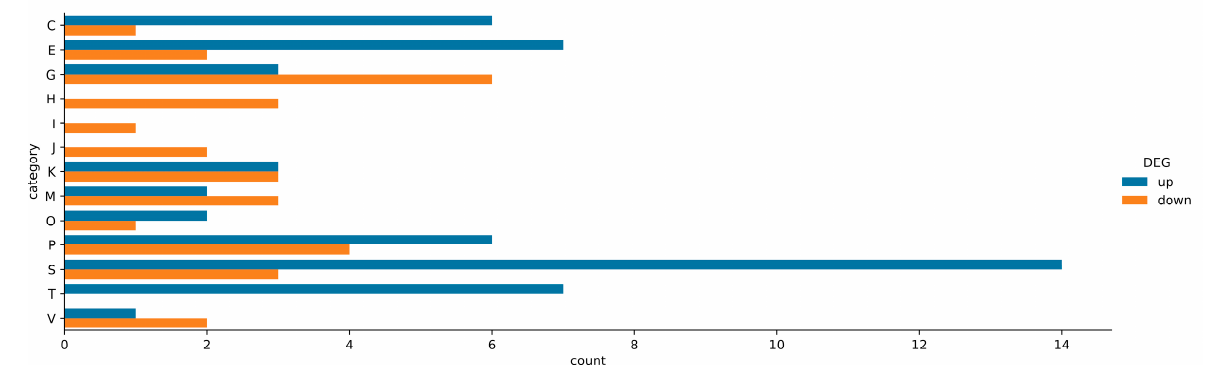
Figure 6. Representation of COG categories comprising DEGs of R. leguminosarum bv. trifolii Δ pssA mutant. COG categories: S—function unknown, C—energy production and conversion, E—amino acid transport and metabolism, G—carbohydrate transport and metabolism, H—coenzyme transport and metabolism, I—lipid transport and metabolism, J—translation, ribosomal structure and biogenesis, K—transcription, M—cell wall/membrane/envelope biogenesis, O—posttranslational modification, protein turnover, chaperones, P—inorganic ion transport and metabolism, T—signal transduction mechanisms, and V—defense mechanisms.